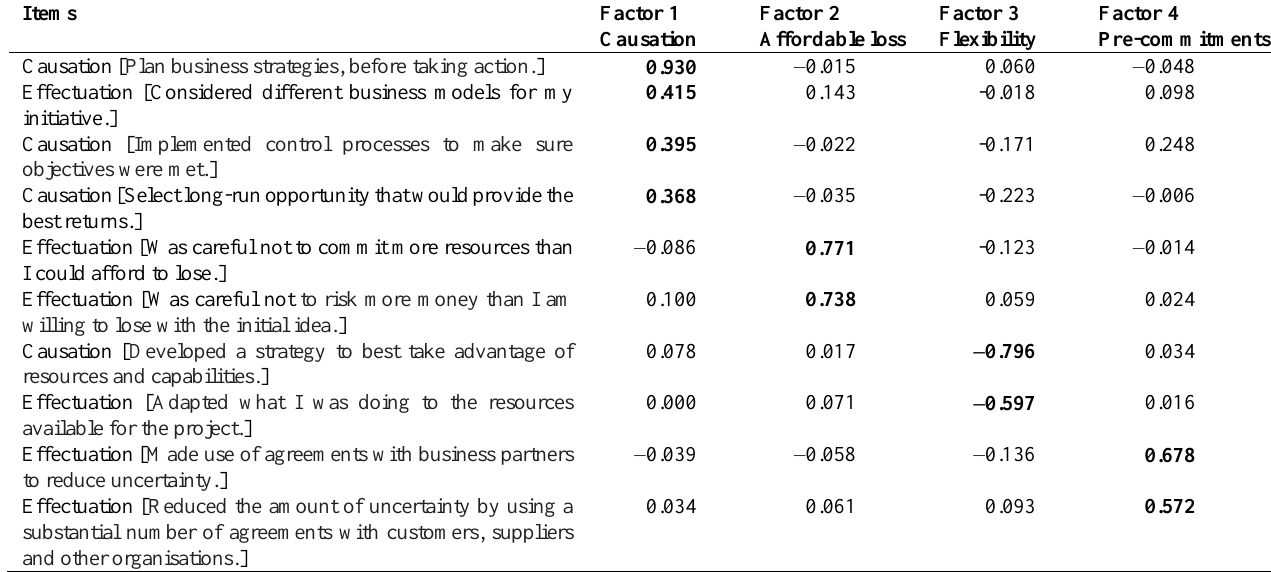
Table 2: Pattern matrix of factor loadings for the dependent variables